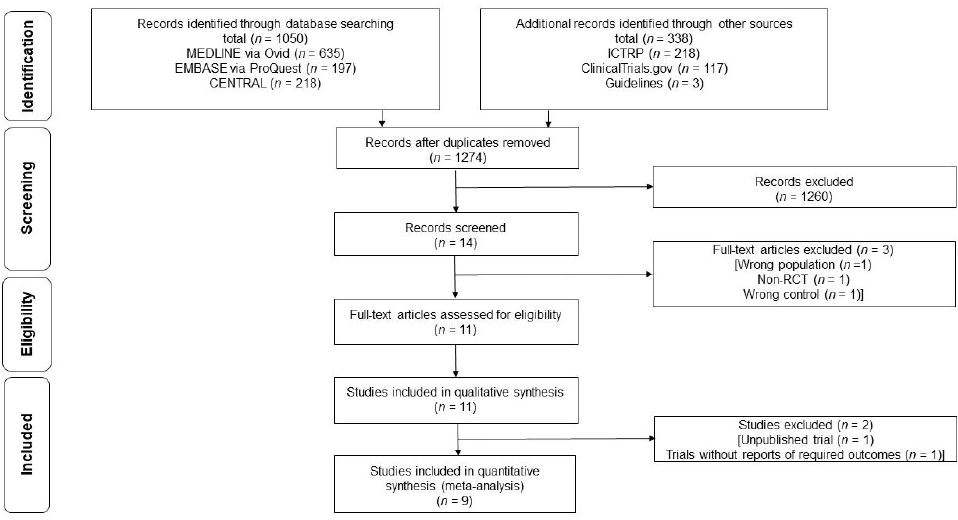
Figure 1. Flow diagram of the literature search